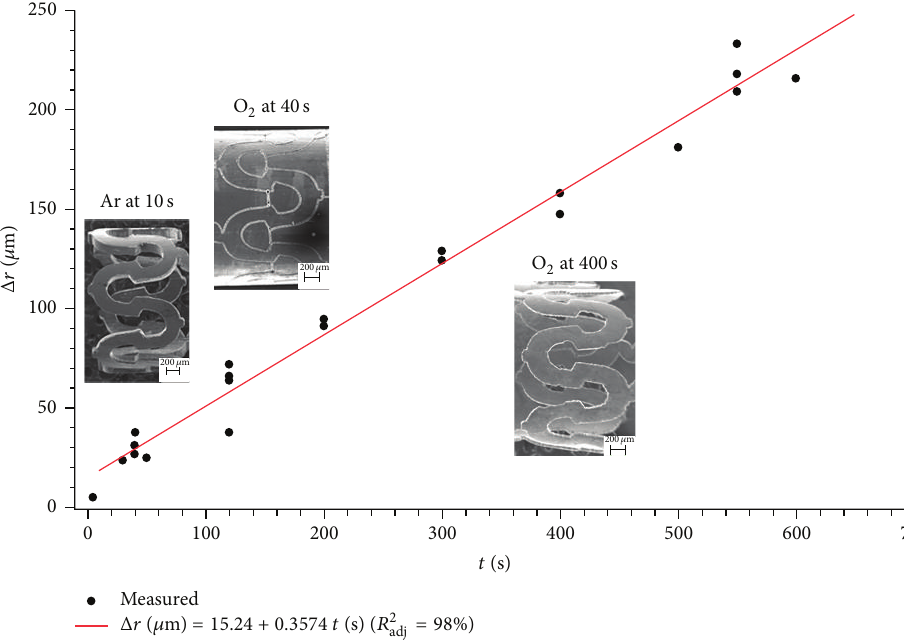
Figure 6: Thickness reduction of AZ31 sheets as a function of etching time, along with the etched stents from different process gas and etching